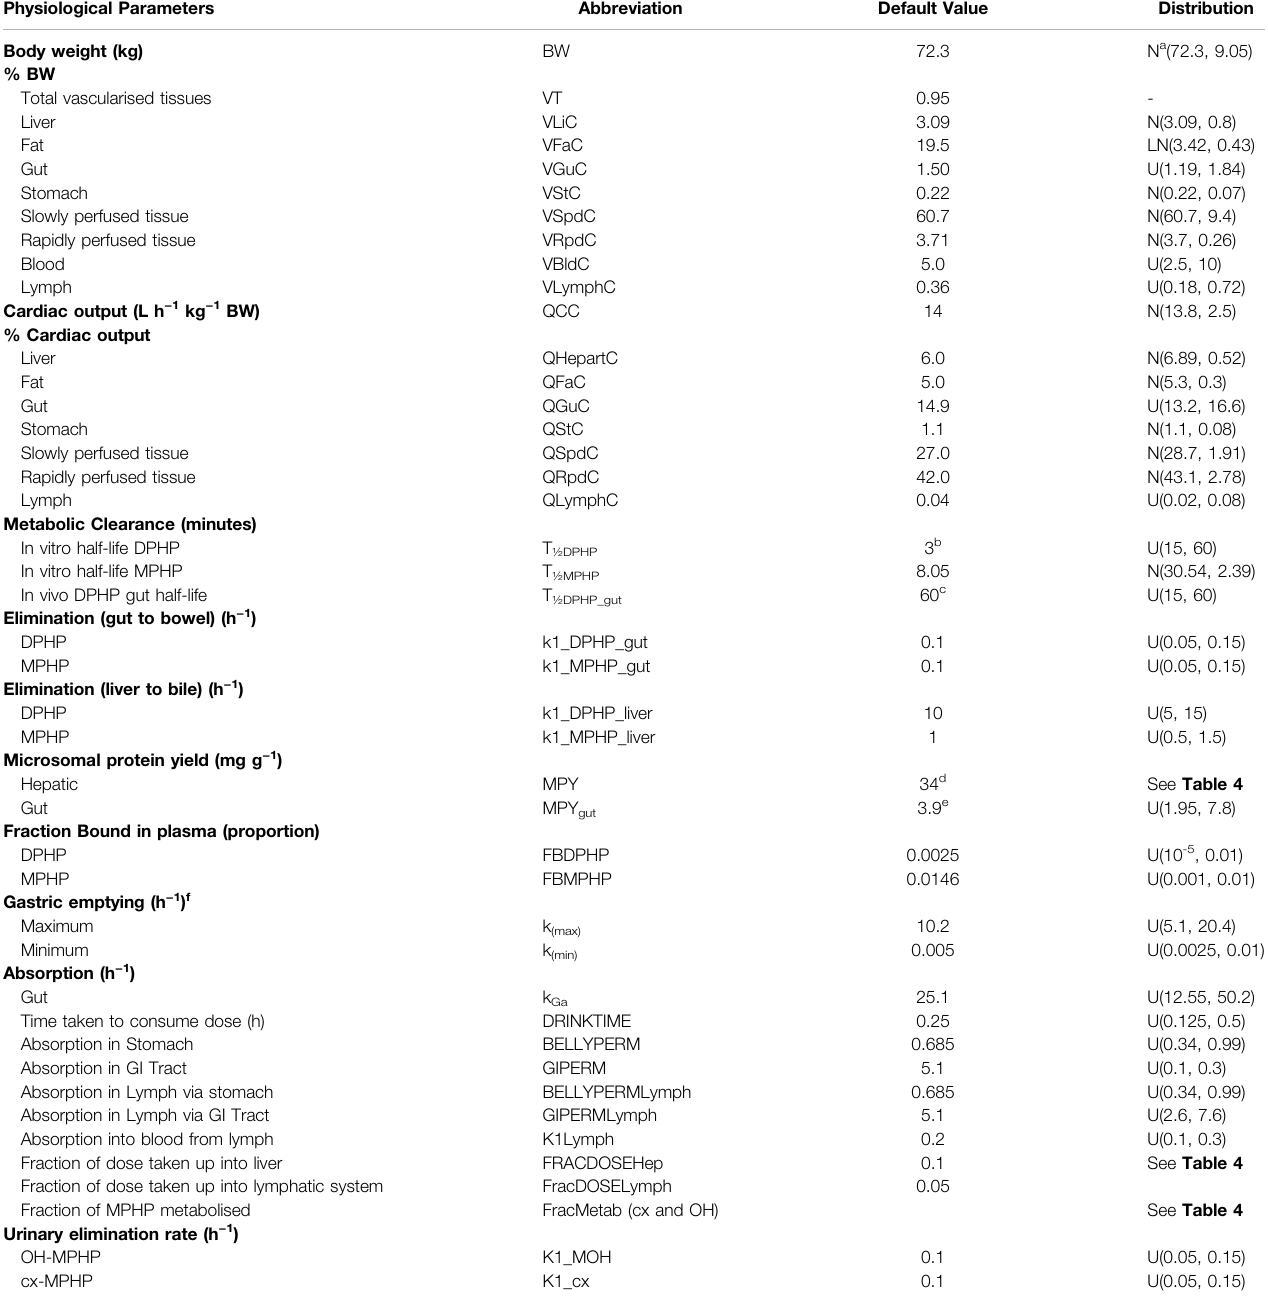
TABLE 3 | Physiological and kinetic default values used in PBPK model and probability distributions applied for uncertainty and sensitivity analyses. Physiological